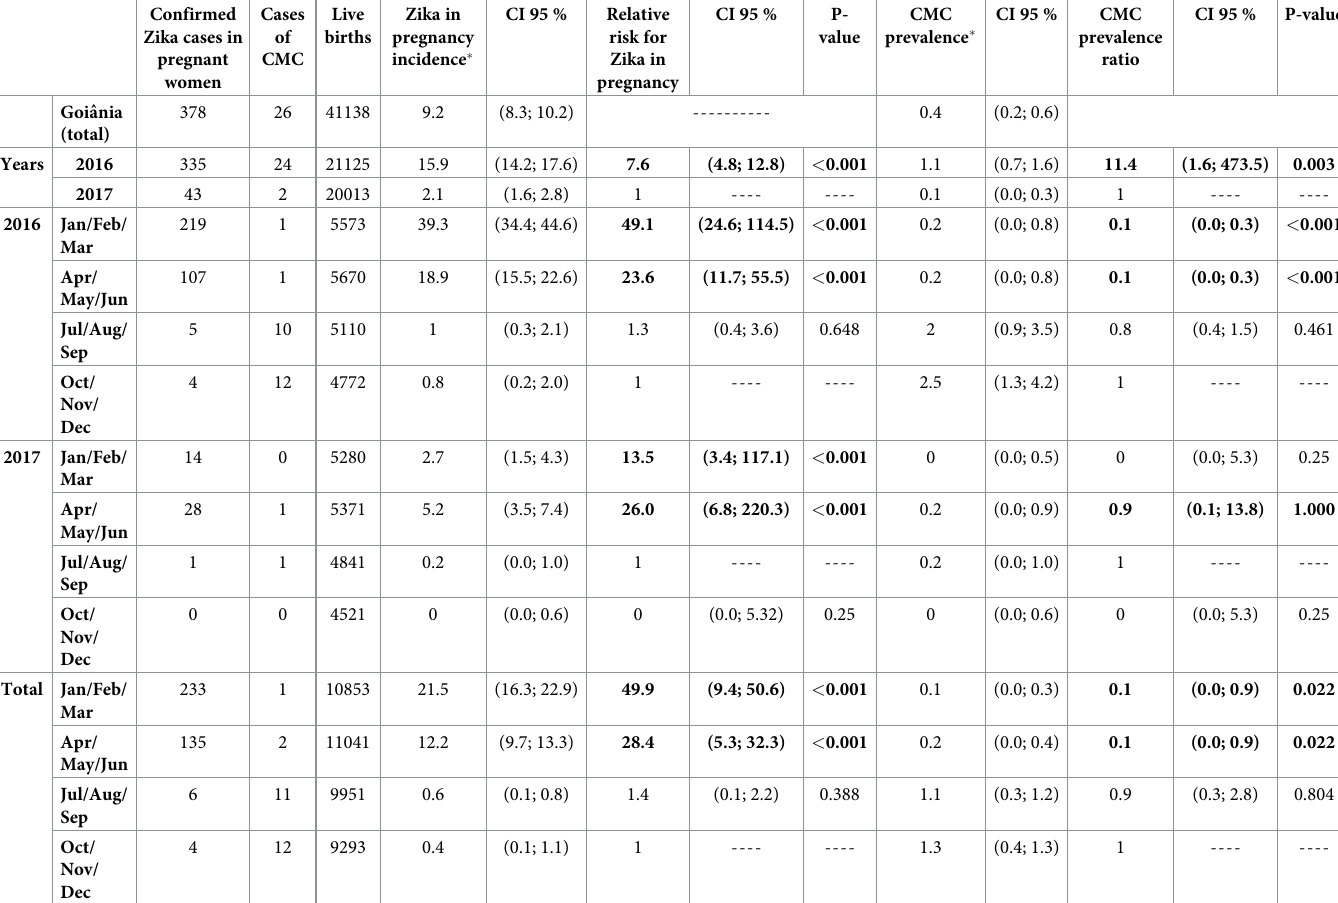
Table 1. Zika virus infection (ZIKVi) in pregnant women, and microcephaly grouped according to a period of 3 months, and a year of notification / birth in Goiania. Confirmed Zika cases